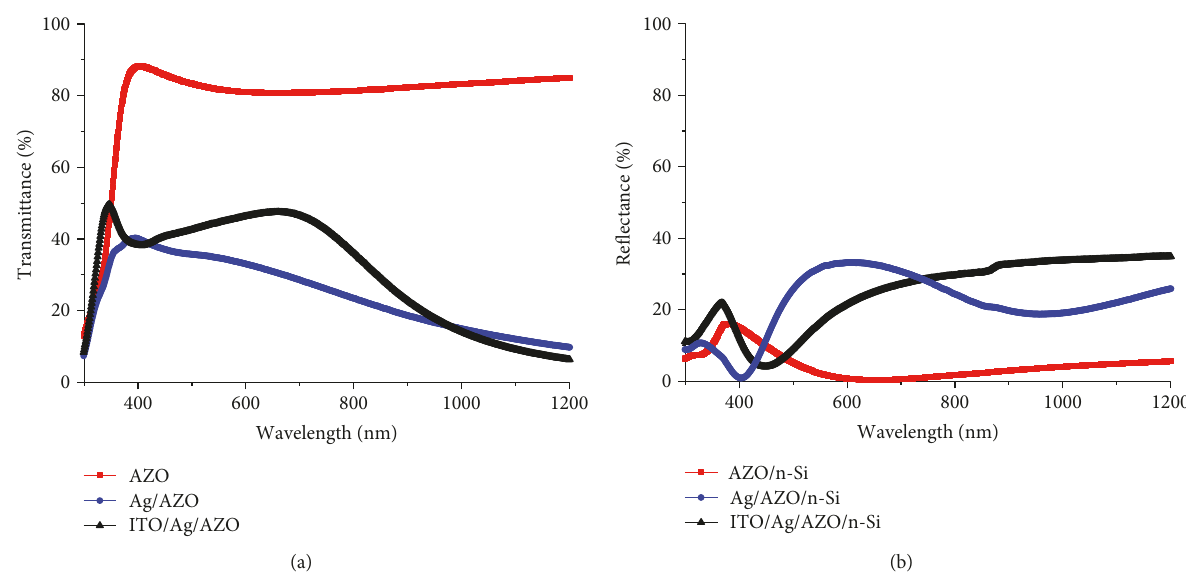
Figure 4: Optical property spectra of AZO, Ag/AZO, and ITO/Ag/AZO devices; (a) transmittance and (b) re fl ectance.